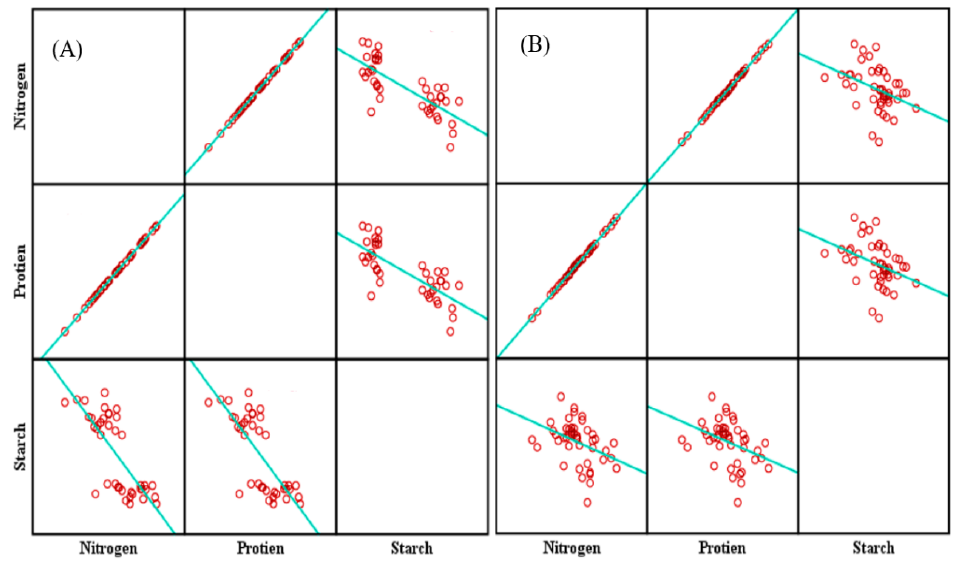
Figure 5. The matrix correlation between the total nitrogen (%) and the crude protein (%) and starch content (%) in the maize grains during 2018 ( A ) and 2019 ( B ).